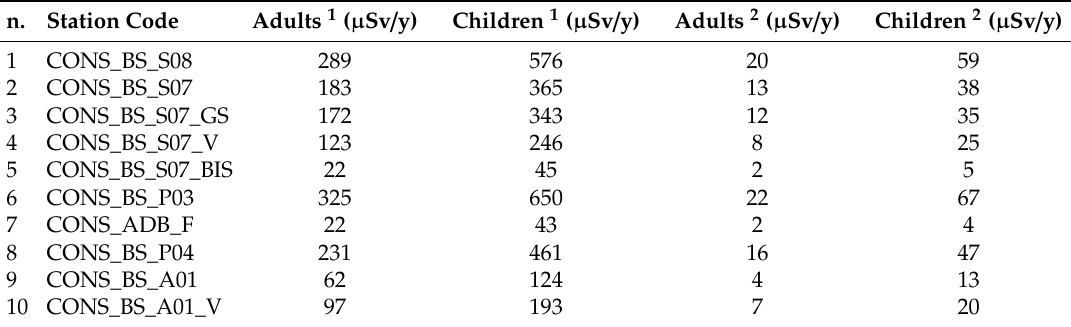
Table 3. Related e ff ective annual dose due to ingestion for adults and children according to 1 the maximum annual consumption and according to 2 the UNSCEAR medium annual